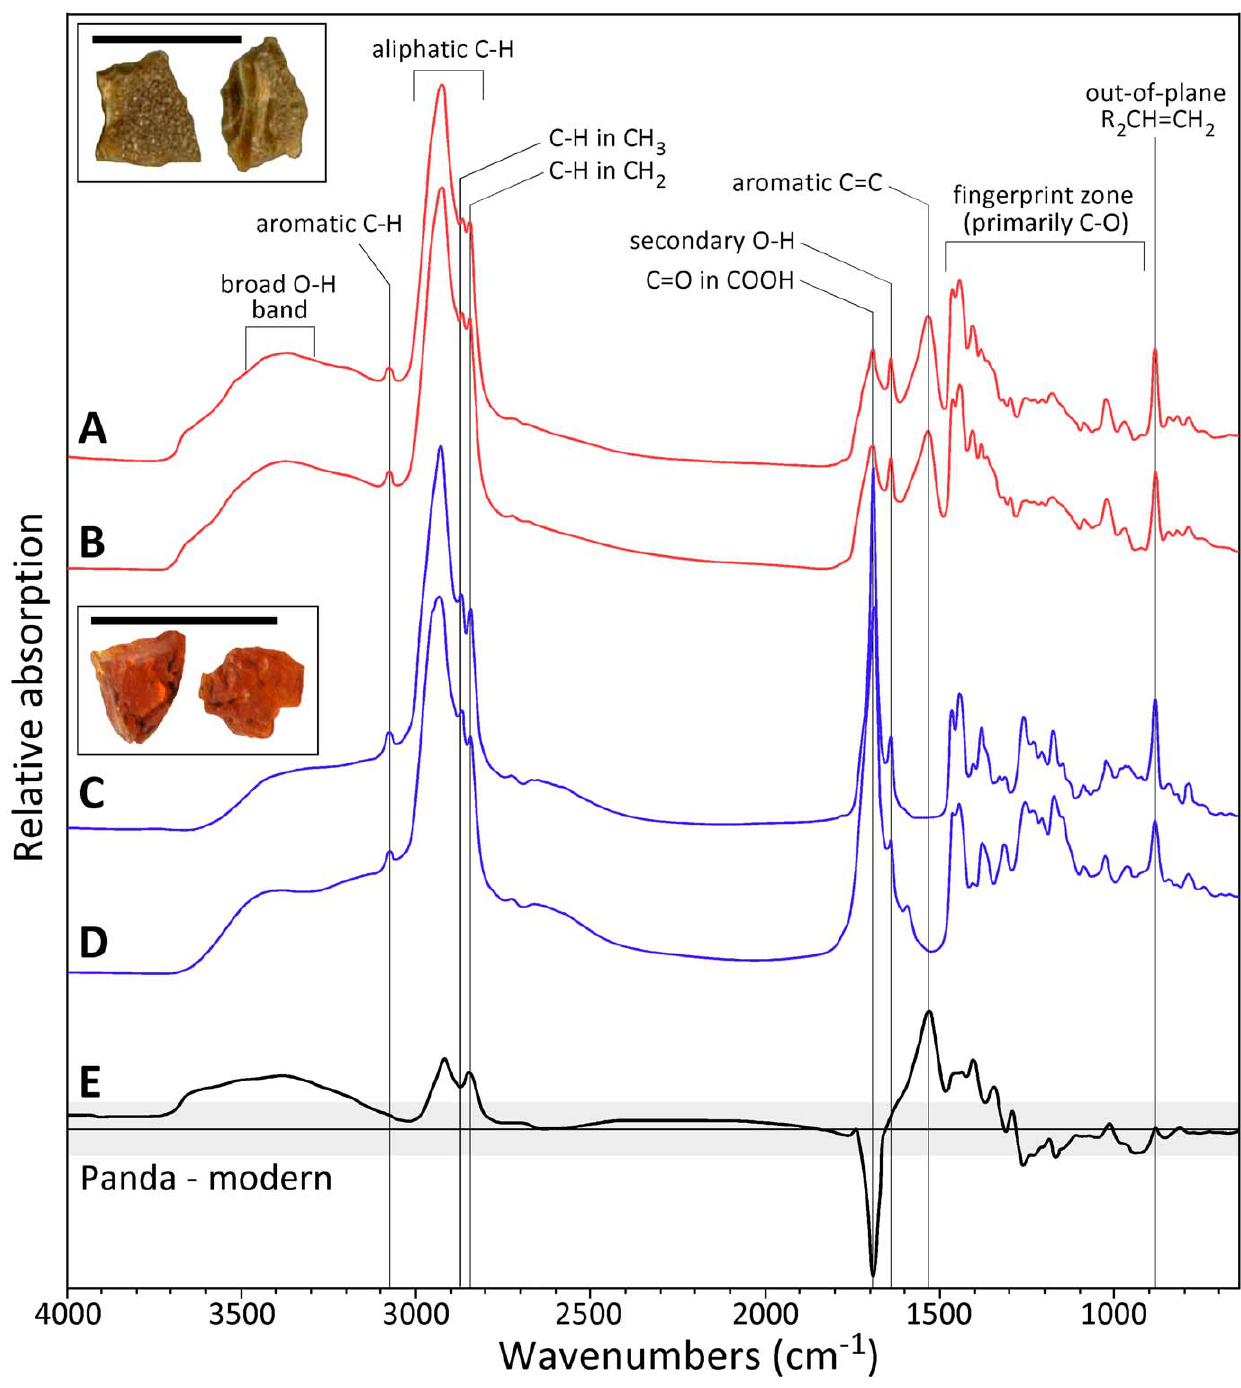
Figure 3. Complete FTIR spectra (650 – 4000 cm 2 1 ) of fossil and modern Metasequoia resins. A–B. duplicate analyses of the amber from Panda wood. C. Middle Eocene amber from post-eruptive sediments in the Giraffe kimberlite pipe, which has not been thermally altered [7,19]. Insets show typical fragments of Panda and Giraffe Metasequoia ambers (scale bars are 5 mm). D. Modern resin from M. glyptostroboides cultivar (Washington DC, USA) is visually identical to the Giraffe material. E. The spectroscopic differences between Panda and modern Metasequoia resins reveals features associated with thermal maturation (grey area is 6 1 SD of the difference). doi:10.1371/journal.pone.0045537.g003 minimize the effects of assumptions regarding RH. It can be characterization exists for both d 2 H and d 18 O [41]. The d 18 O d 2 H shown that the d 2 H and d 18 O of source waters inferred from environmental water and environmental water values obtained from Panda wood cellulose using constant enrichment factors Panda wood cellulose plot closely to the local meteoric water line between water and cellulose were used (Table 1), in order to (Fig. 4A), strongly supporting the contention that mechanisms of